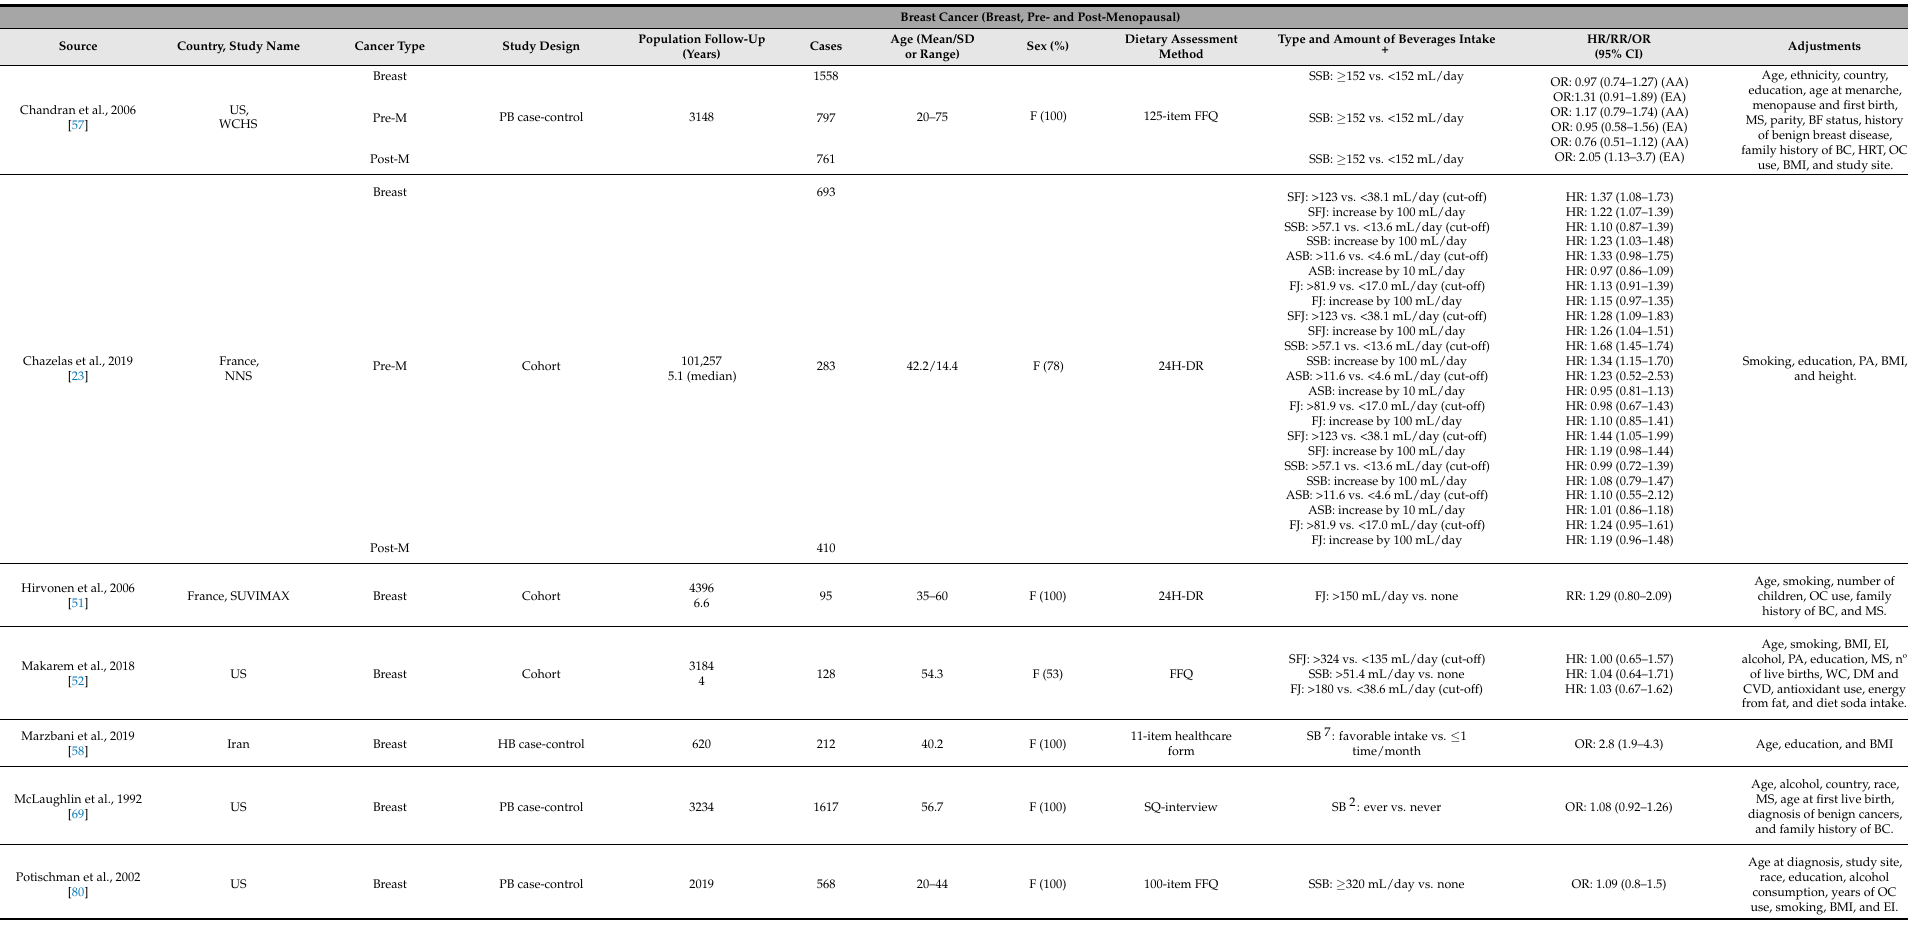
Table 1. Overall characteristic of the included